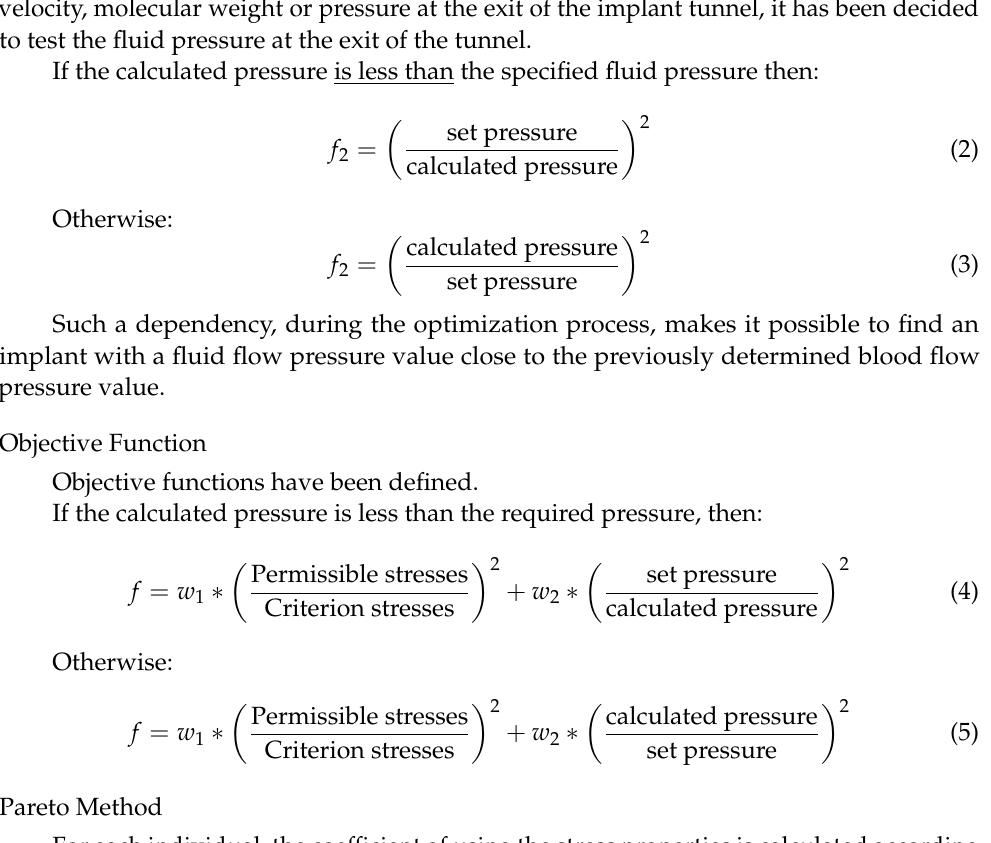
Criteria of Concept Evaluation—Blood